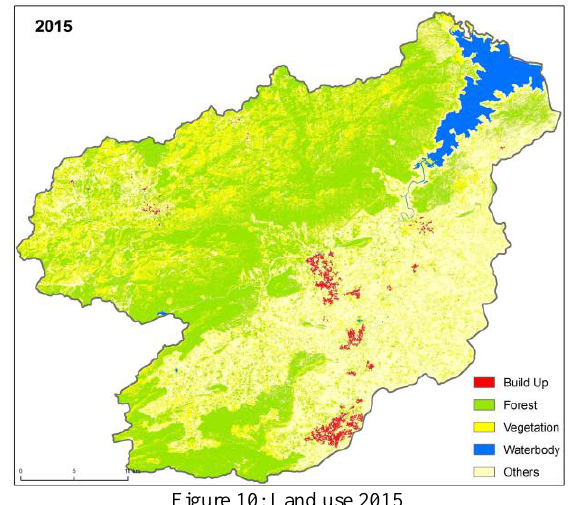
Figure 10: Land use 2015